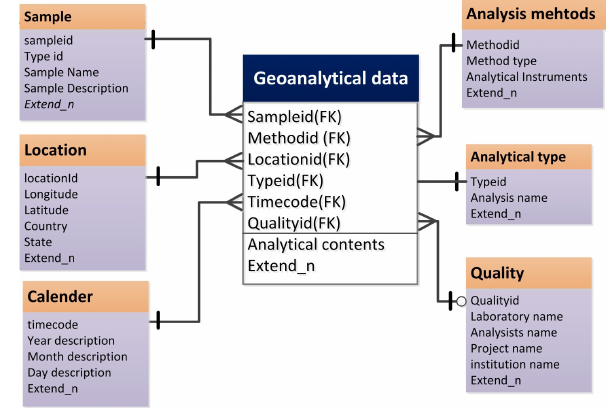
Figure 4. Logical data model (LDM) of the geoanalytical data